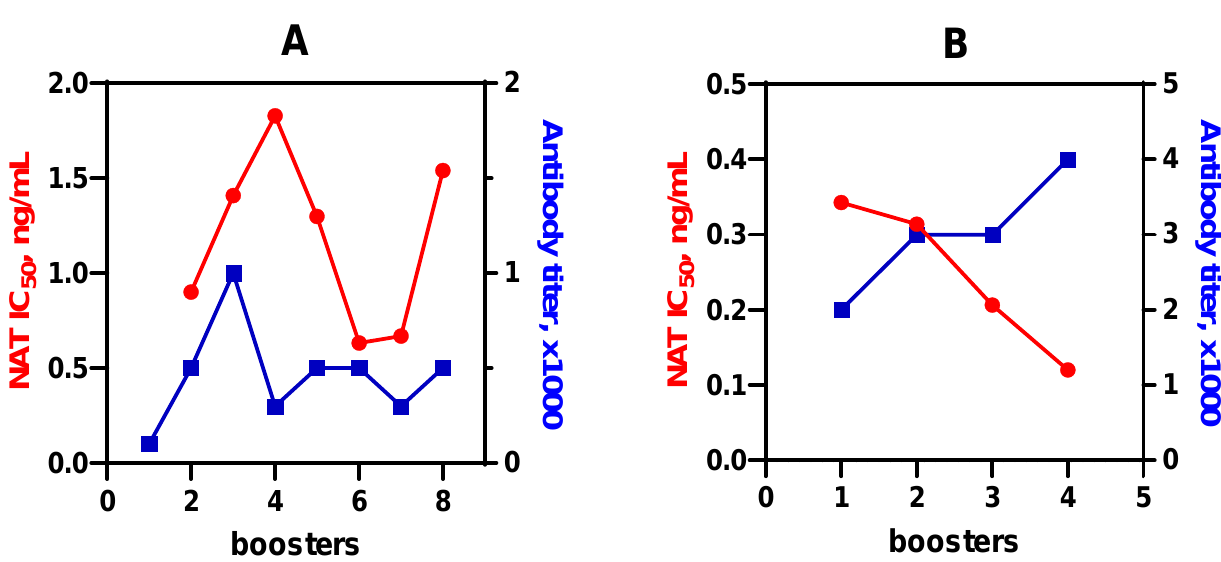
During the immunization course, blood samples were taken from rabbits to monitor the immune response. Maturing antibodies were analyzed by their binding activity (ti- ters) and, more importantly, by the sensitivity (IC 50 ) of NAT determination. In addition, different coating antigens were compared as factors affecting the assay sensitivity and specificity [20,21]. As a result of the comparison, it was found that the heterologous binding site of NAT to Gel made the coating antigens more preferable. Thus, the better pair of immunoreagents, namely, anti-TTd-adh-NAT – Gel(pi)-NAT and an- ti-TTd-aca-NAT – Gel-NAT(ae) were selected, and these interactions were optimized Figure 2. UV-Vis spectra of immunogen conjugates TTd-adh-NAT ( A ) and TTd-aca-NAT ( B ). Conju- (Figure 3). gates and modified TTd, 0.1 mg/mL; NAT, 10 µ g/mL in water.